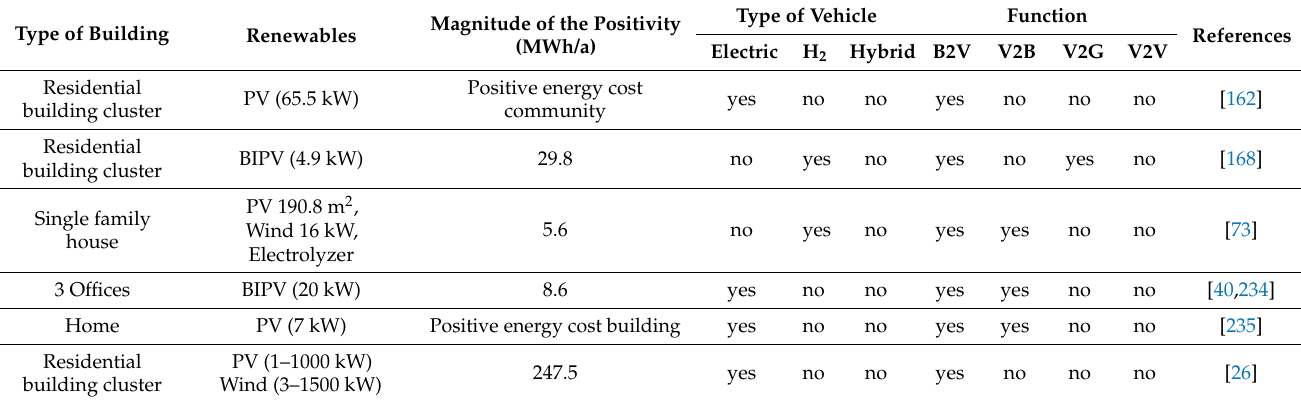
Table 9. Impact of the new energy vehicles on PEB/PEC, and their energy